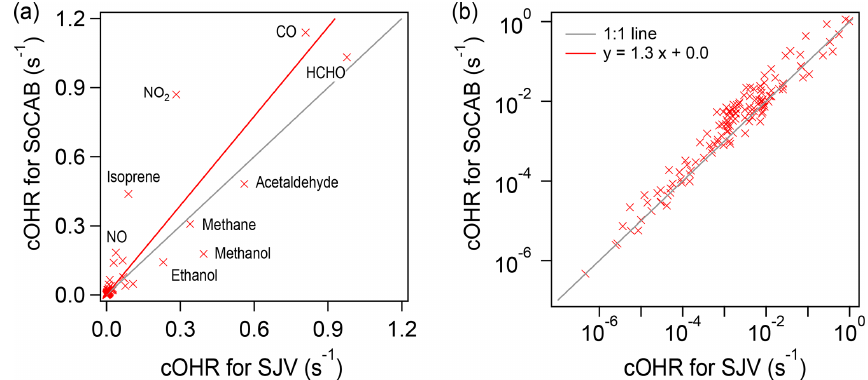
Figure 4. Scatterplot of cOHR SOCAB versus cOHR SJV for the individual species in the (a) linear scale and (b) logarithmic scale. The red line represents linear regression using the orthogonal distance regression